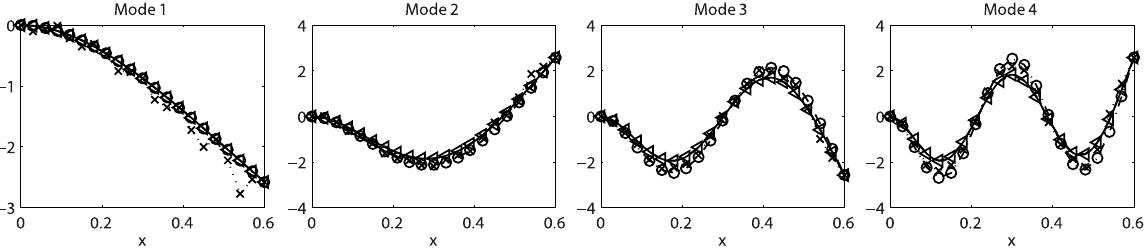
Fig. 3. The modal functions (solid line), the KLMs with N s = 20 (dotted-dashed line with ◦ ), the SMs with N s = 20 (dotted line with × ) and the modal functions approximated from the SD approach with N s = 20 (dashed line with (cid:3) ).